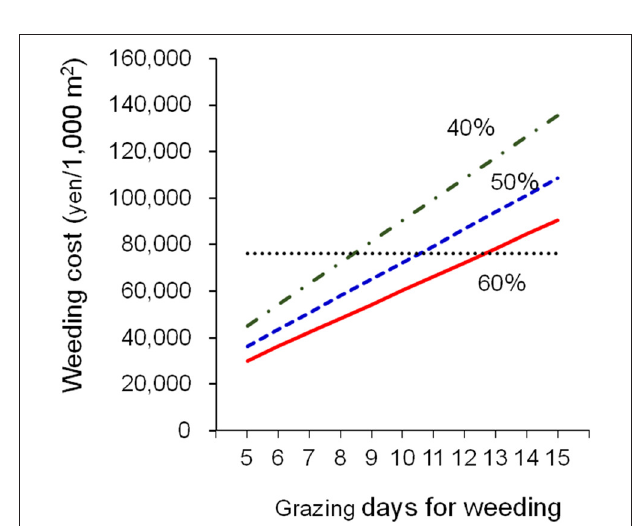
FIGURE 2 | Comparison of weeding cost by goat grazing and human mowing with a brush cutter. Cost for goat weeding at an annual operating rate (days) of 40% (84 days: - · -), 50% (105 days: - -), and 60% (126 days: —). Cost for human weeding ( ······ ).